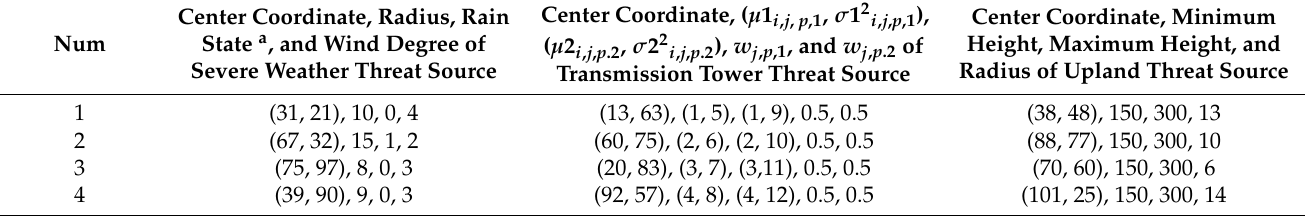
Table 7. Parameters setting methods of threat sources.